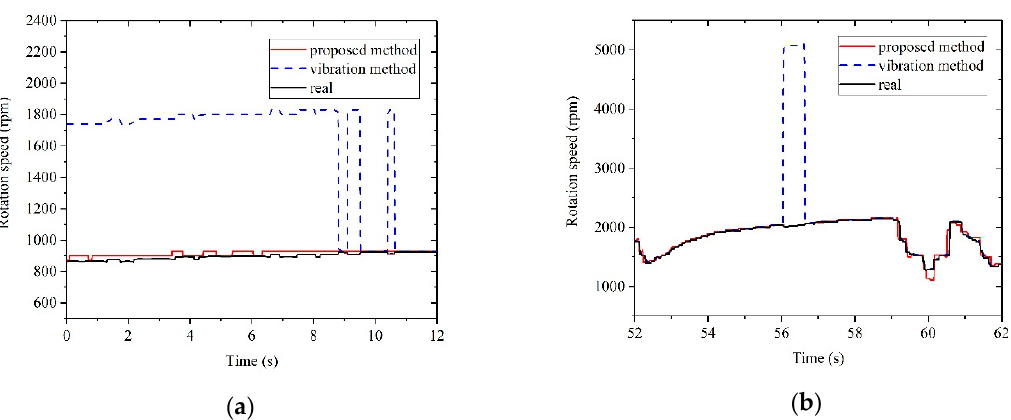
Figure 8. ( a ) Zoomed-in figure of box A in Figure 7; ( b ) Zoomed-in figure of box B in Figure 7.